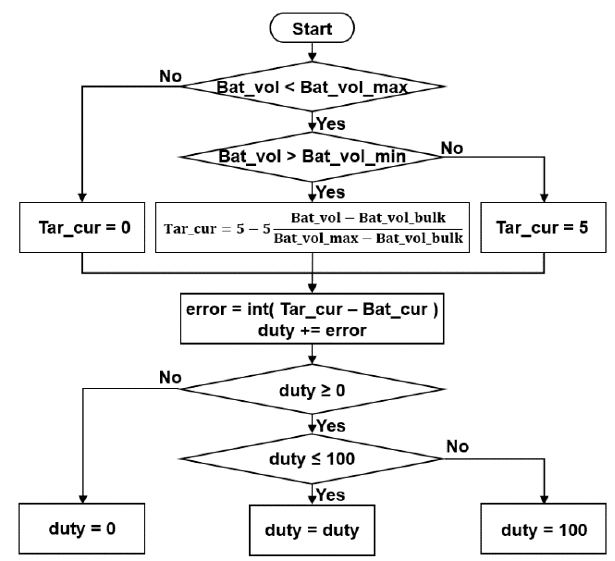
Figure 4. Conceptual software of the HPC.